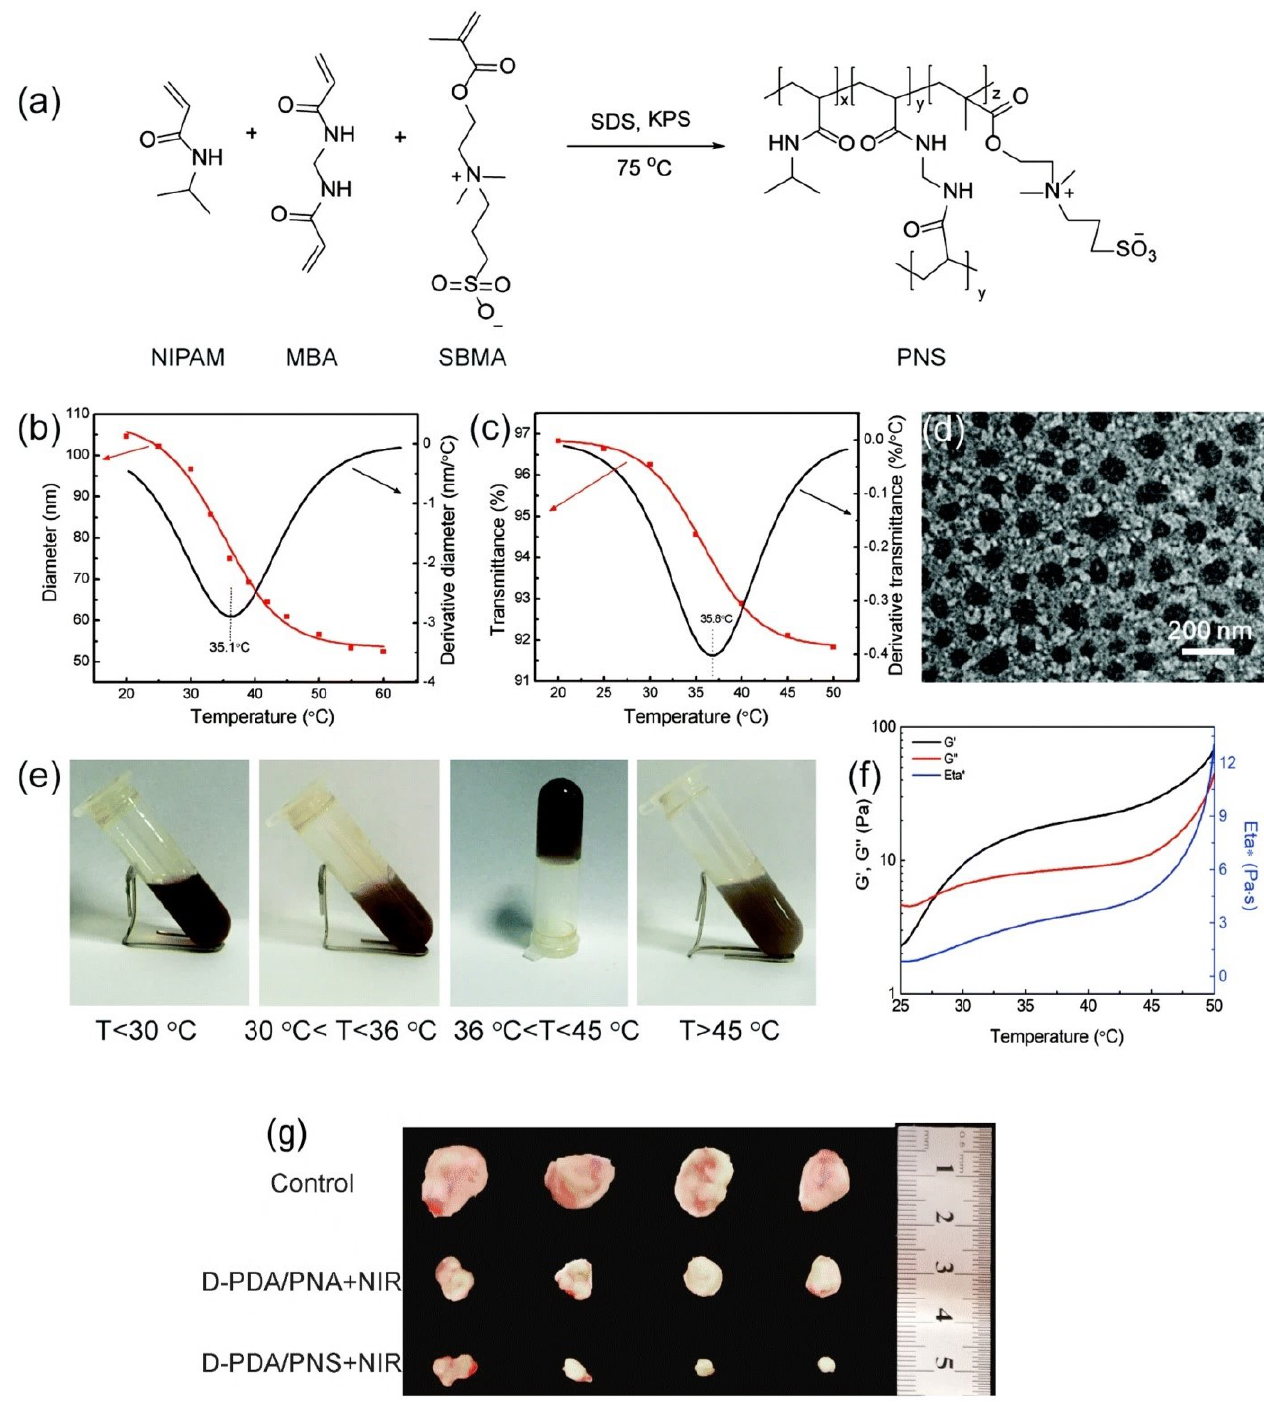
Figure 2. Zwitterionic thermosensitive PNS nanogels. ( a ) Schematic synthesis of PNS nanogels. ( b ) Temperature dependence of hydrodynamic diameters and ( c ) temperature dependence of PNS transmittance. ( d ) TEM image. ( e ) Photos of the sol–gel phase transition. ( f ) Rheology of the sol–gel phase transition. ( g ) In vivo antitumor effect: the corresponding photographs of the peeled tumors after intratumoral injection for 14 days. Reproduced from [29], with permission from © The Royal Society of Chemistry